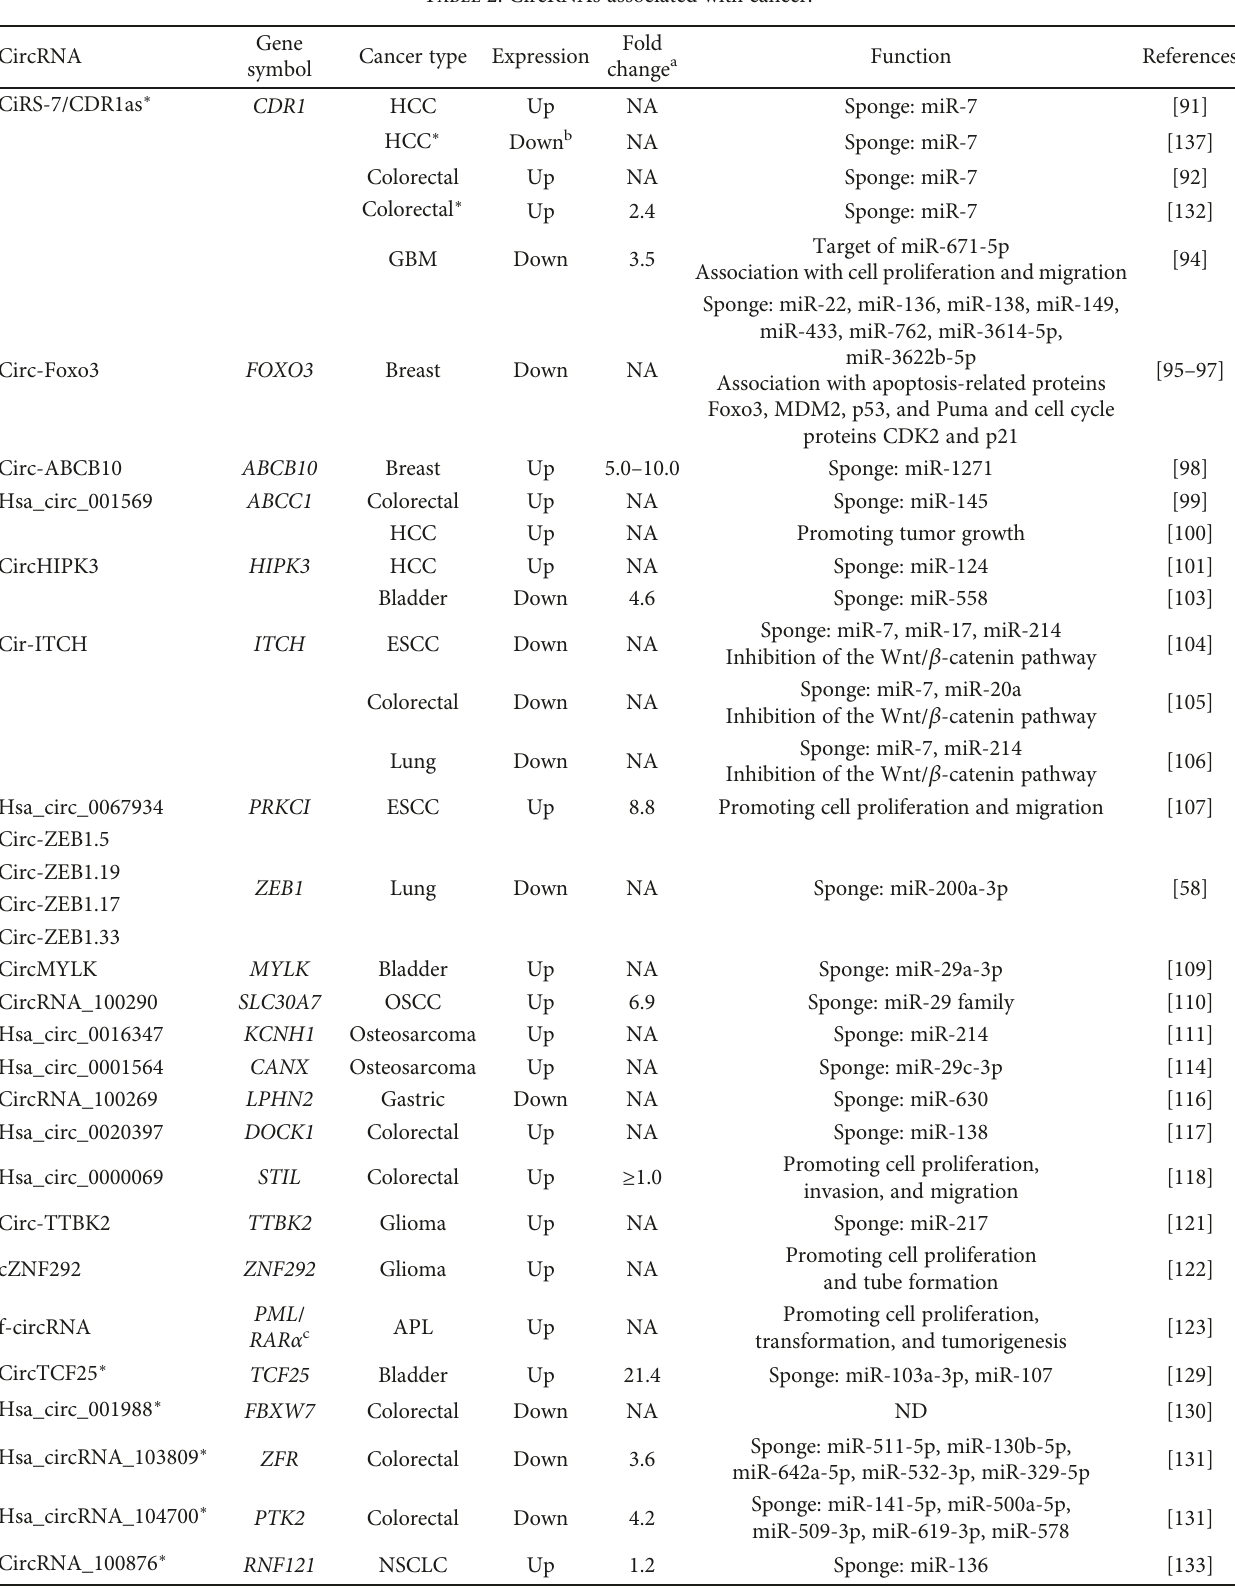
Table 2: CircRNAs associated with